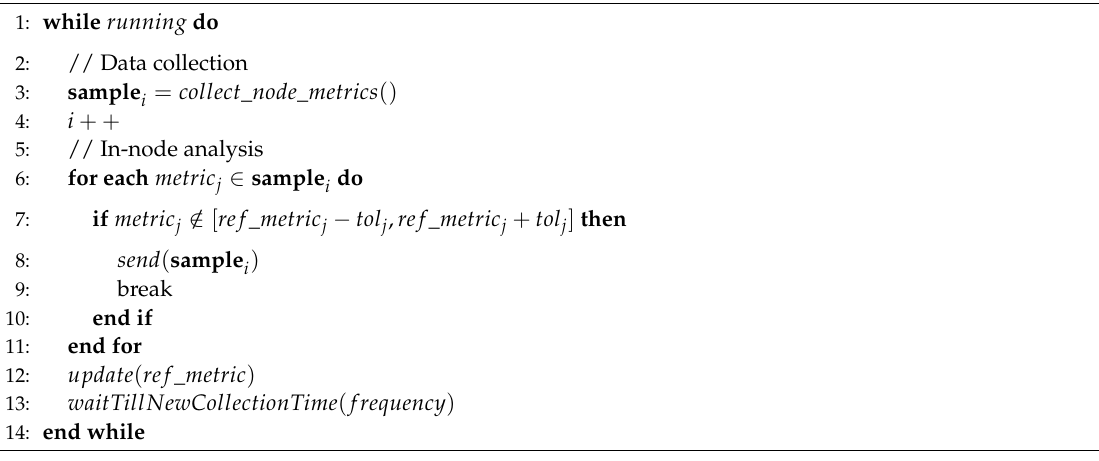
Algorithm 1 LIMITLESS DaeMon Monitor algorithm.